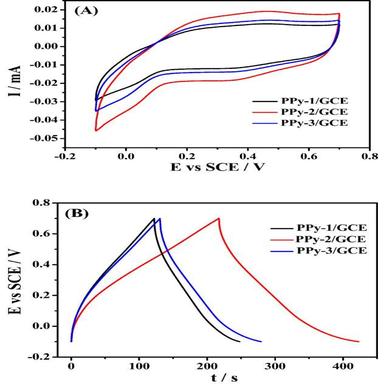
Cyclic voltammograms (A) and GCD curves (B) of PPy-1/GCE, PPy-2/GCE and PPy-3/GCE in 1.0 M H2SO4. Scan rate of (A), 5 mV s − 1; current density of (B), 1 A g − 1.